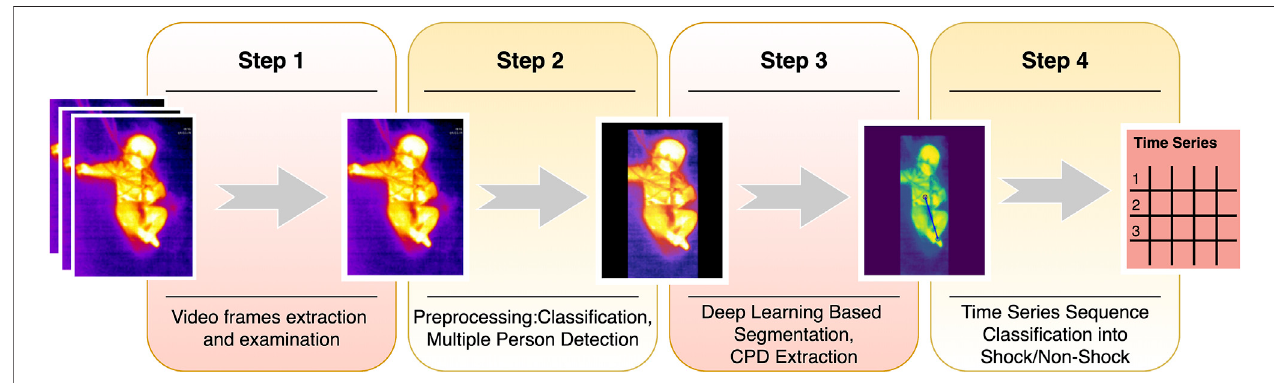
FIGURE 1 | Shock prediction steps. The summary of the shock pipeline shows the steps from video frame extraction to shock prediction. Step 1 comprises sampling videos toextract frames. Step 2 classi fi es frames into covered or uncovered,whilealso fi nding the presence of multiple people in the frame and mask them, to avoid confusion. The masked images are then input to the ResUNet based segmentation model and CPD is hence extracted. The series of CPDs are then passed through a time-series sequence classi fi er, and fi nally, the predictions are made for shock for the next 6